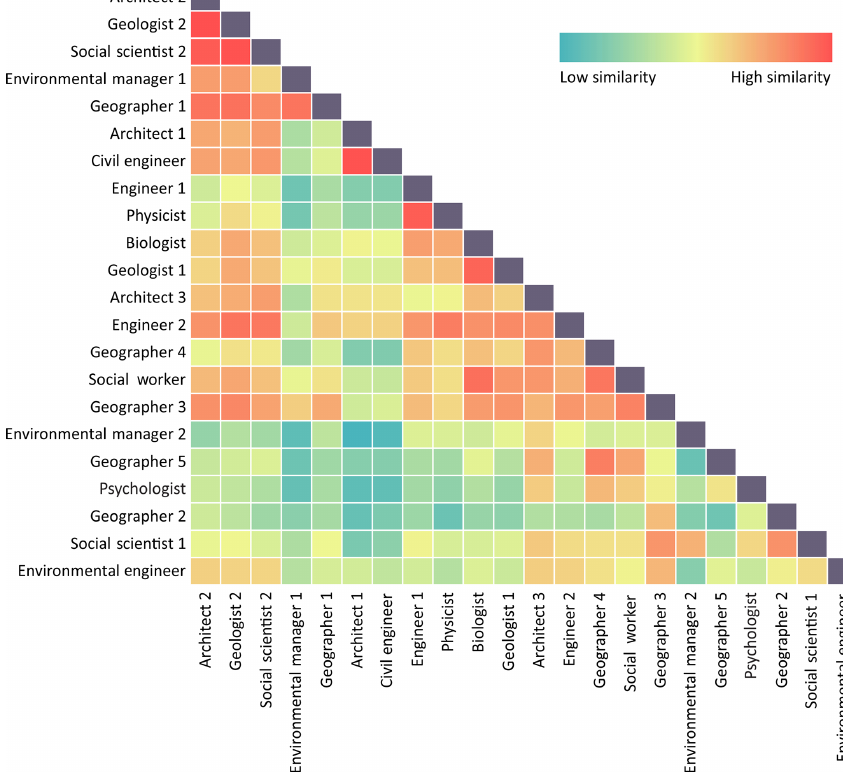
Figure 8. Heat map of similarities between experts’ weights. The colour gradient from green to red indicates increasing